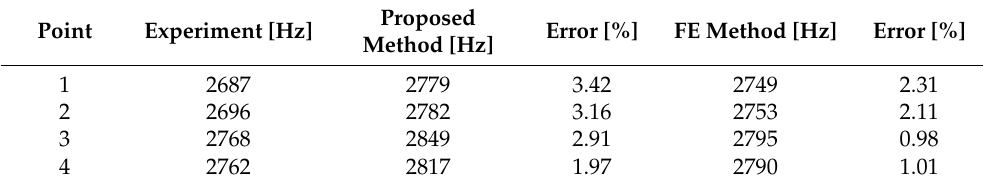
Table 1. Natural frequency comparison between experiment and prediction.